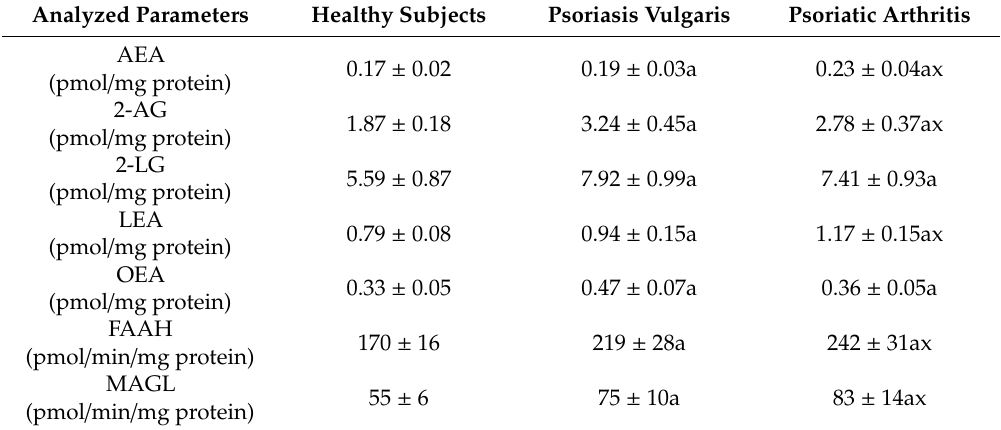
Table 2. The level of endocannabinoids and enzymes degrading them (FAAH and MAGL) in mononuclear cells of patients with psoriasis vulgaris (n = 32) and psoriatic arthritis (n = 16)